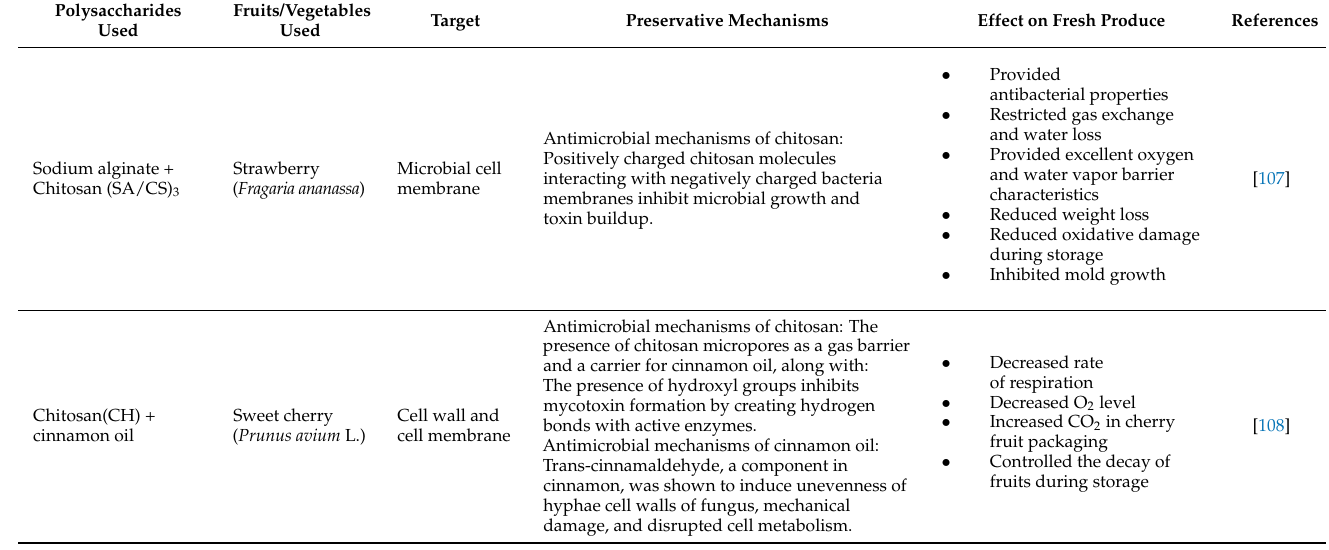
Table 2. Application of polysaccharide’s barrier properties against physical and mechanical impacts, chemical reactions, and microbial